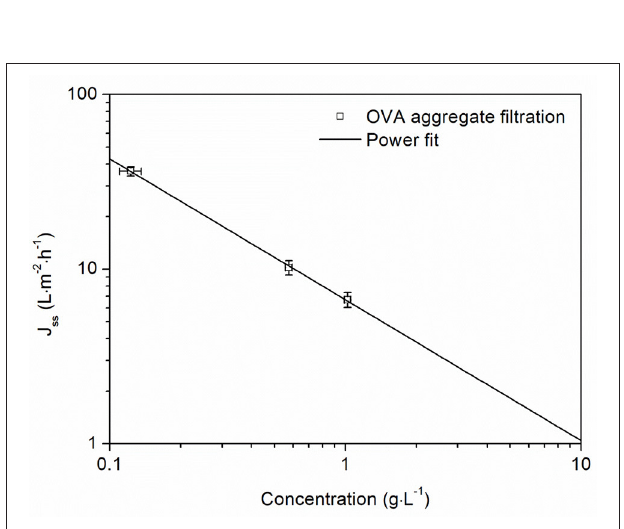
FIGURE 5 | Steady-state flux as a function of OVA aggregate concentration. Vertical error bars are standard deviations from the Bradford assay ( n = 3) and horizontal error bars are standard deviations from the average steady-state flux during the last 5min of filtration. Filtrations were carried out at 1.5 bar TMP and 28 ◦ C with a 50nm cut-off ceramic membrane. The power fit gave the equation J ss = 6.68 × c OVA − 0.806 (adj. R ² =